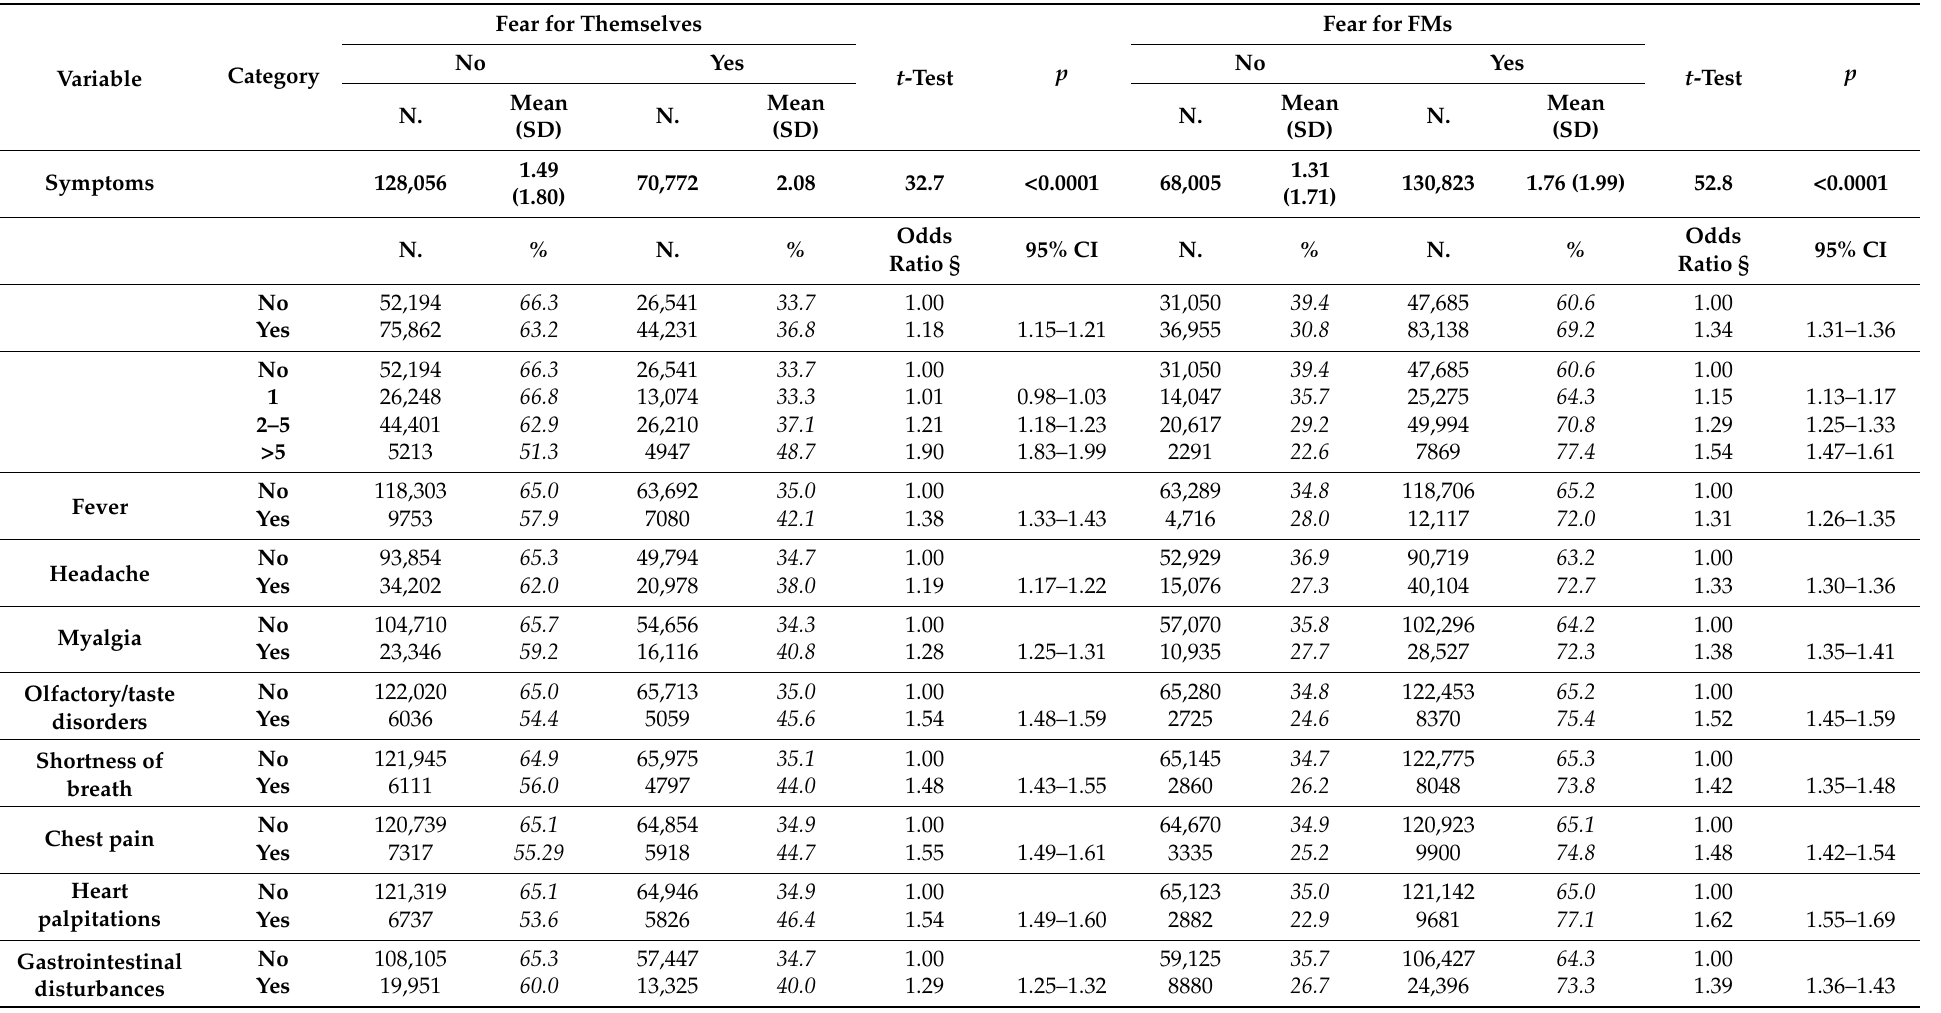
Table 2. Fear for themselves and for FMs according to symptoms obtained by the self-administered EPICOVID19 survey questionnaire.